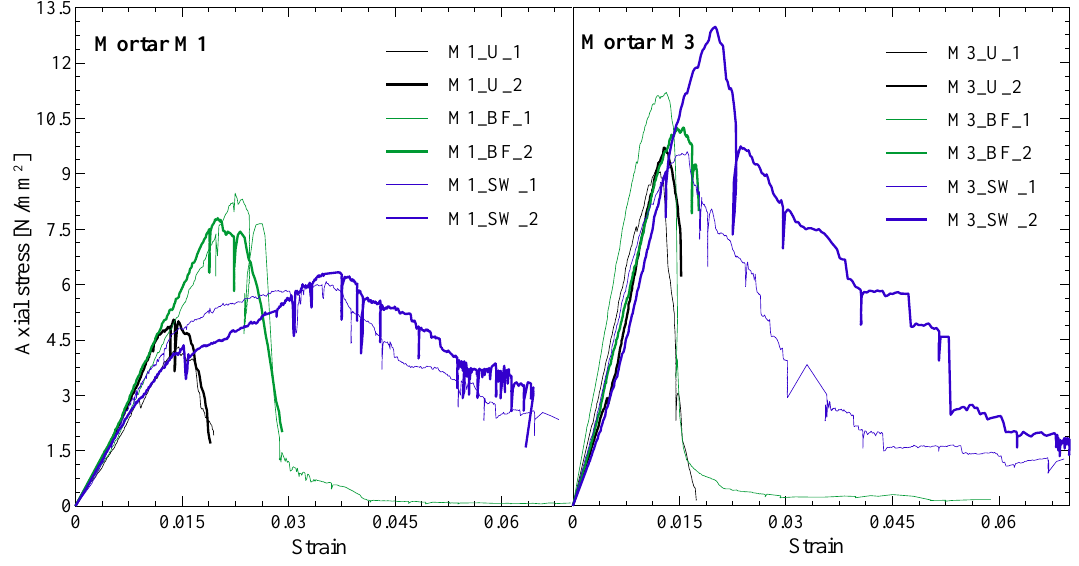
Figure 5. Axial stress-strain curves of unconfined and confined clay brick masonry columns.